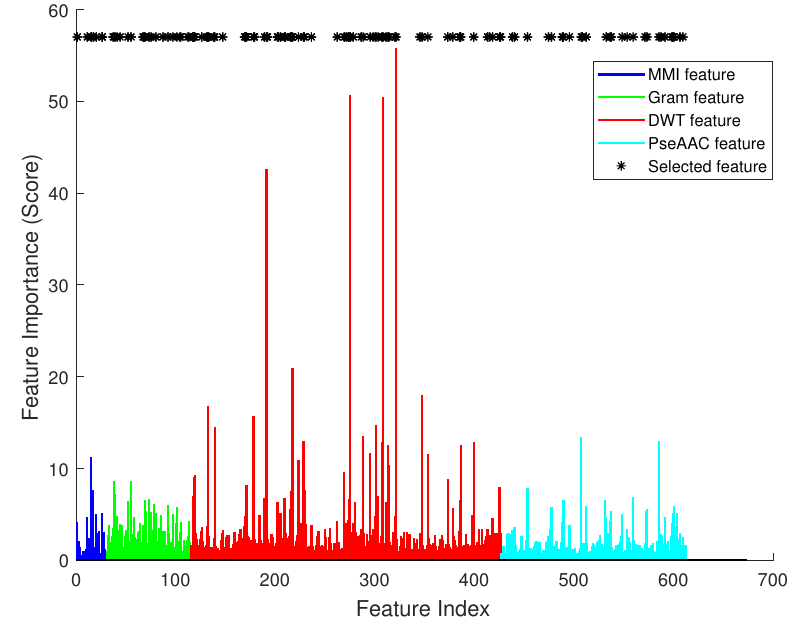
Figure 4. The importance score of each